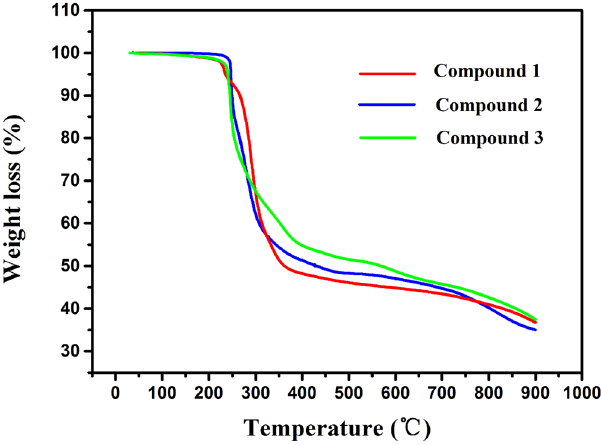
Figure 6. TG curves of compounds 1 – 3